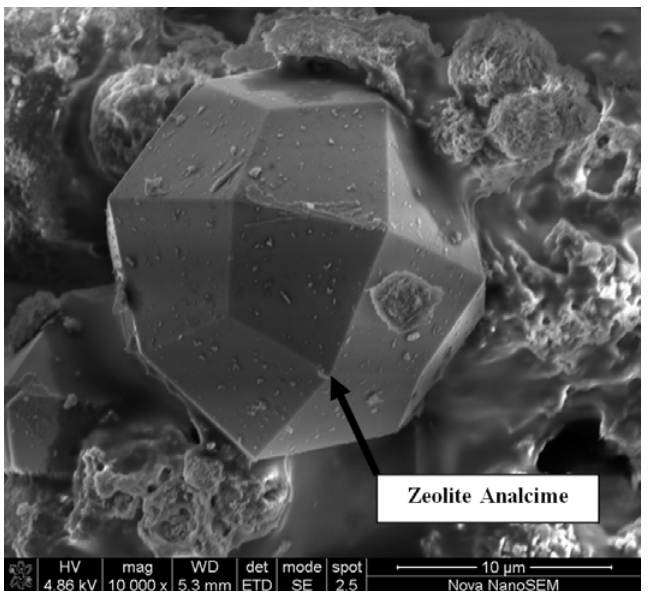
Figure 10. Micrographs taken of zeolite analcime obtained after Run 10, at a magnification of 10,000 times.